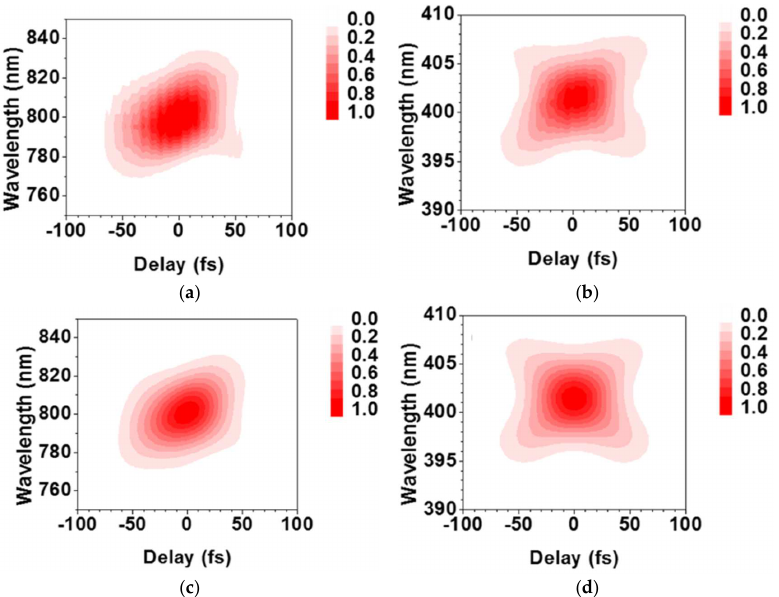
Figure 3. Measured ( a , b ) and retrieved ( c , d ) SD FROG ( a , c ) and SHG FROG ( b , d ) traces for the reference pulse.